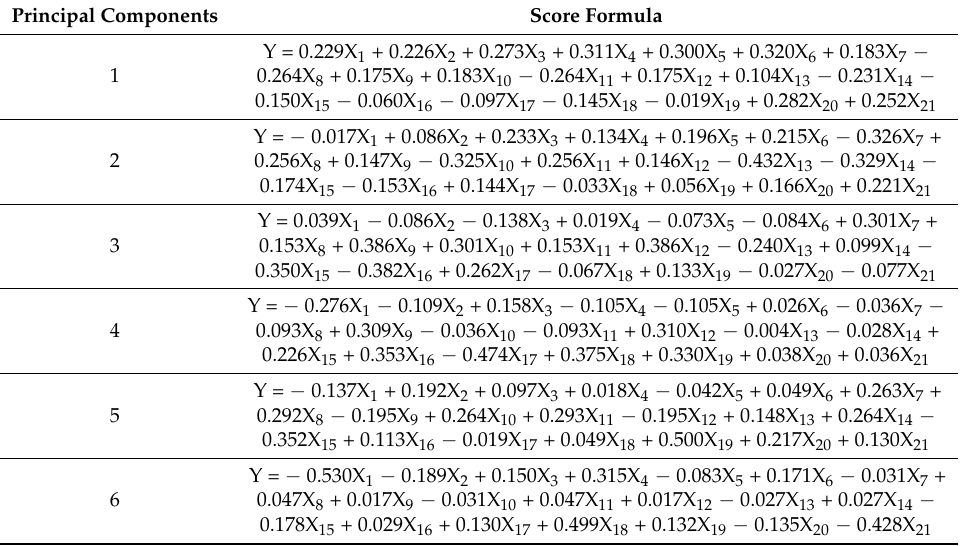
Table A1. Final score formula for the six principal